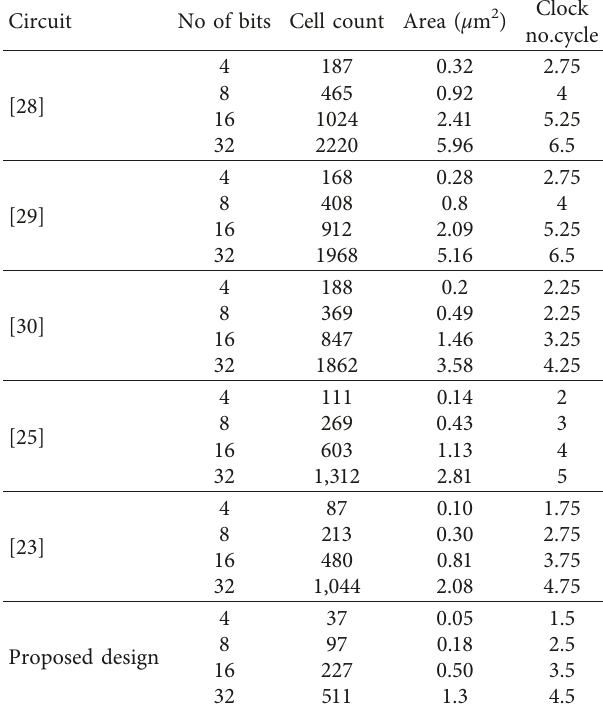
Table 2: Comparison results of parity generators.